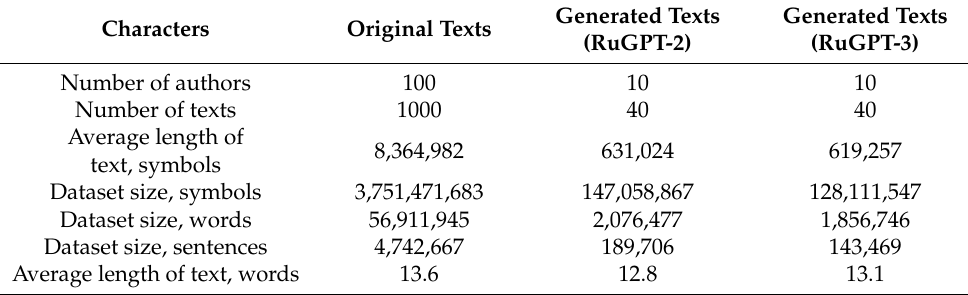
Table 1. Information about the literary